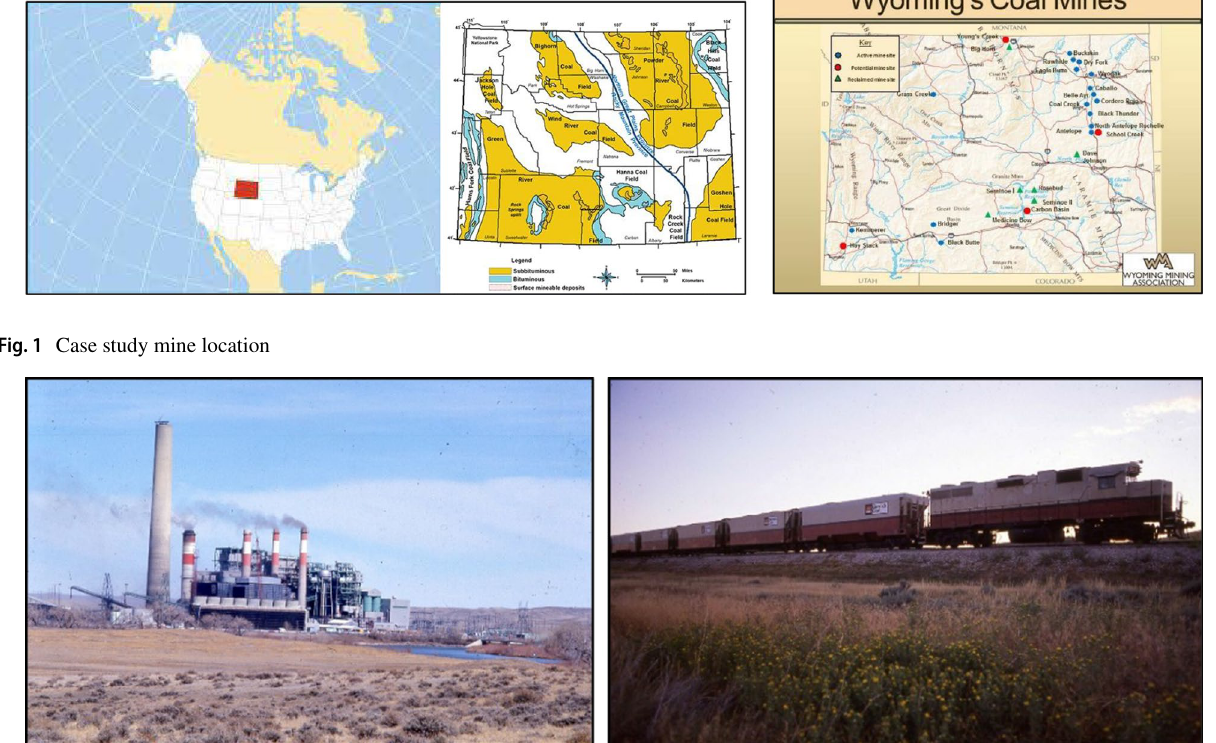
Fig. 2 Power plant and coal transport from the